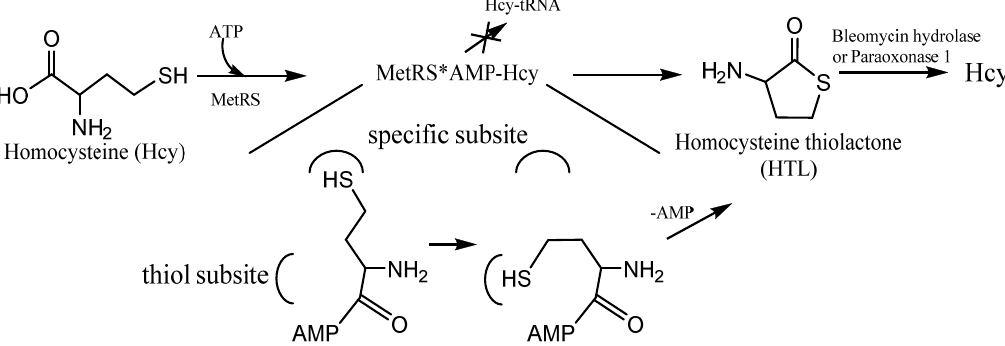
Figure 3. The mechanism of Homocysteine thiolactone (HTL) formation: editing of Hcy at the active site of aminoacyl-tRNA synthetases. MetRS—methionine-tRNA synthetase. MetRS*AMP-Hcy—MetRS and AMP-Hcy complex.